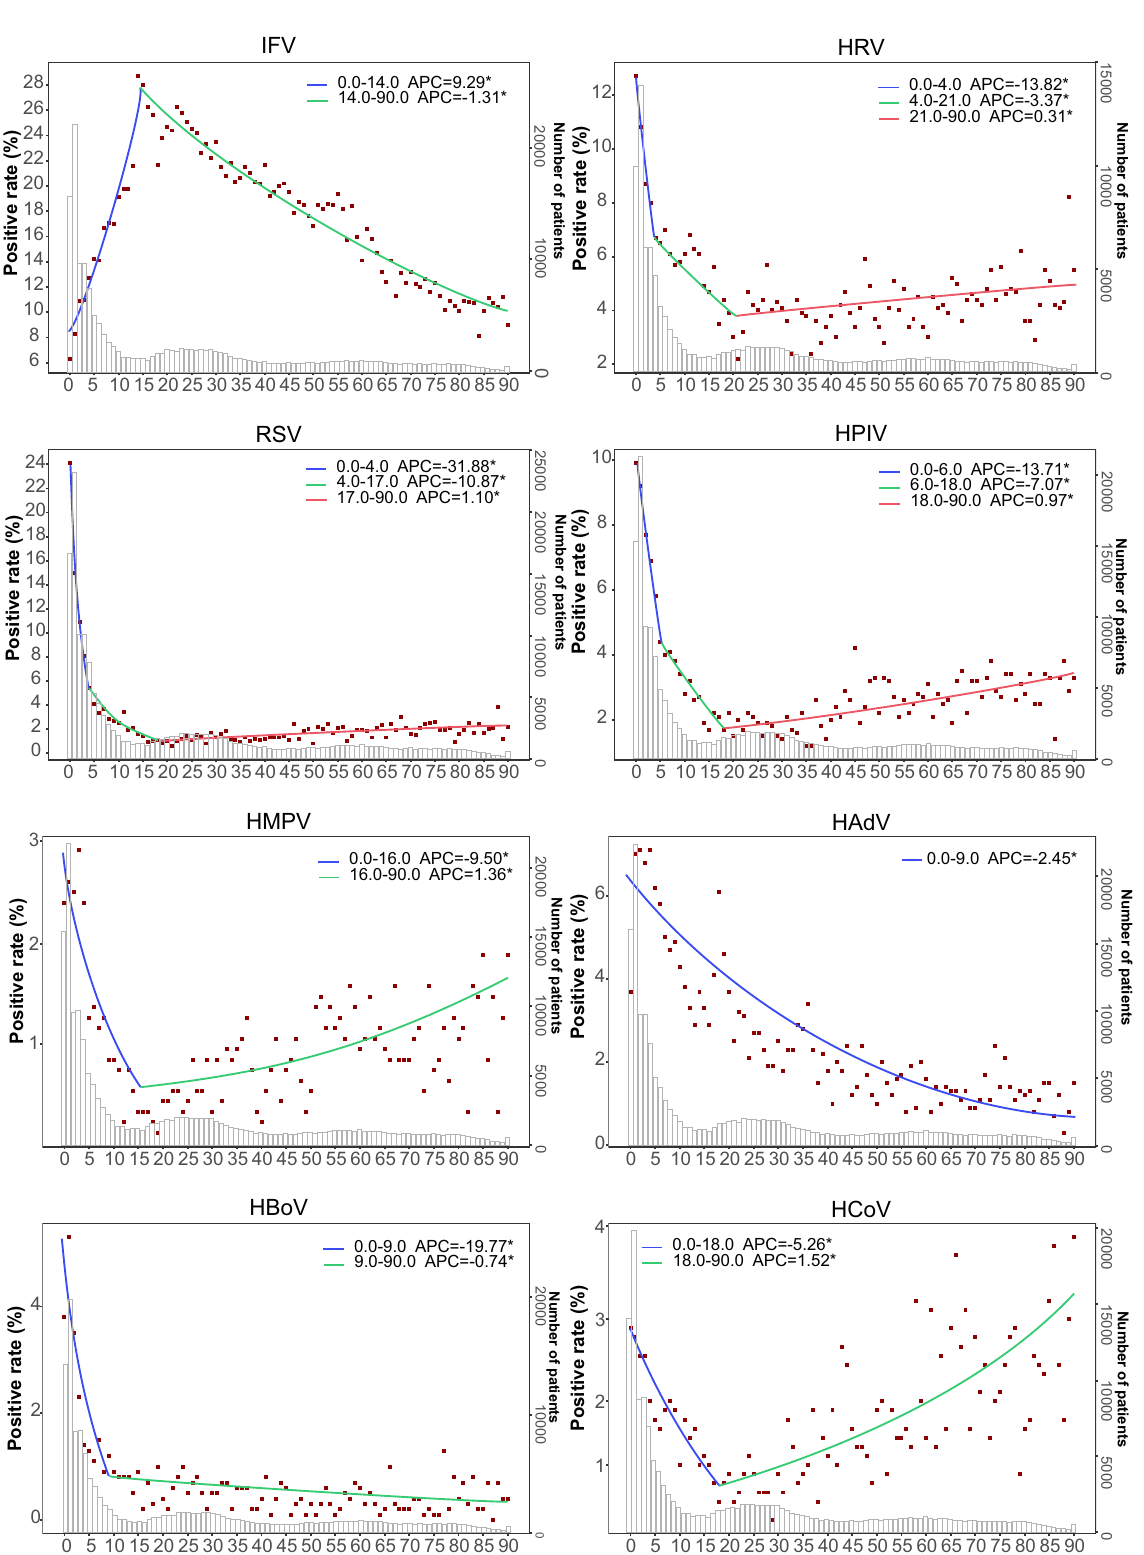
Fig. 4 The Join-Point regression of the positive rates of each tested virus by age of patient. A red point indicates the mean positive rate of patients in terms of age and the colored curves indicate fi tted patterns by the red points. The colored segments indicate the fi tting values of the Join-Point regression. Legends give the Annual Percent Change (APC) value of each fi tted curve for each tested virus. *indicates that the APC is signi fi cantly different from zero at two-sided P < 0.05. The p values were not adjusted for multiple comparisons. The gray bars indicate the number of patients tested for each